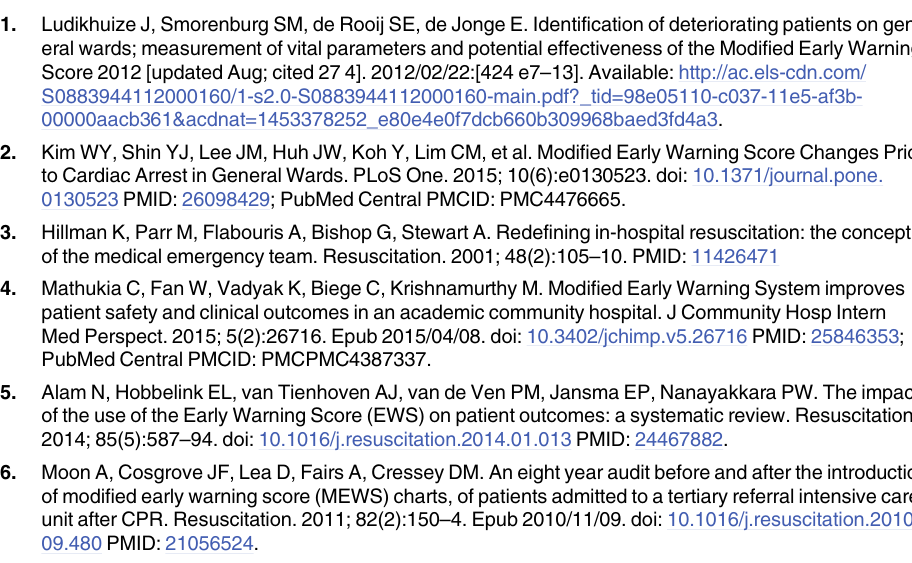
S1 Table. Actions undertaken on patients by clinical staff after critical score reached. (cid:3) Since it is part of disease/treatment or patient is familiar with abnormalities. S2 Table. Categorisation of actions of clinical staff. (cid:3) Since it is part of disease/treatment or patient is familiar with